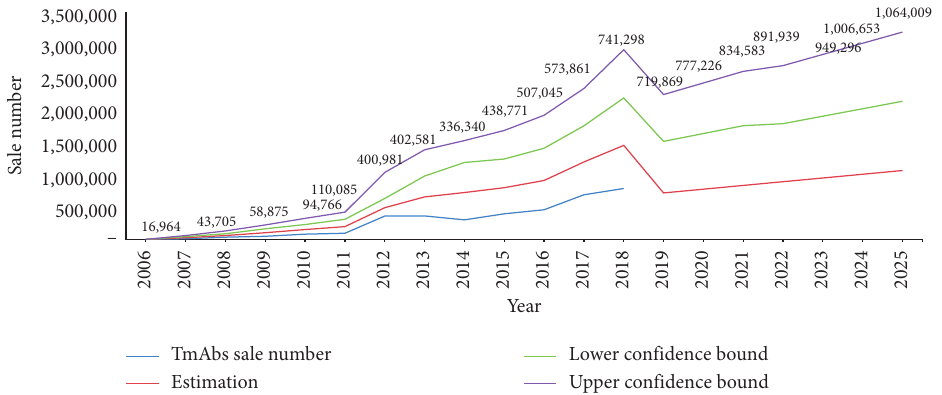
Figure 4: Sales of MTA items in Iran (2006–2018) and estimation to